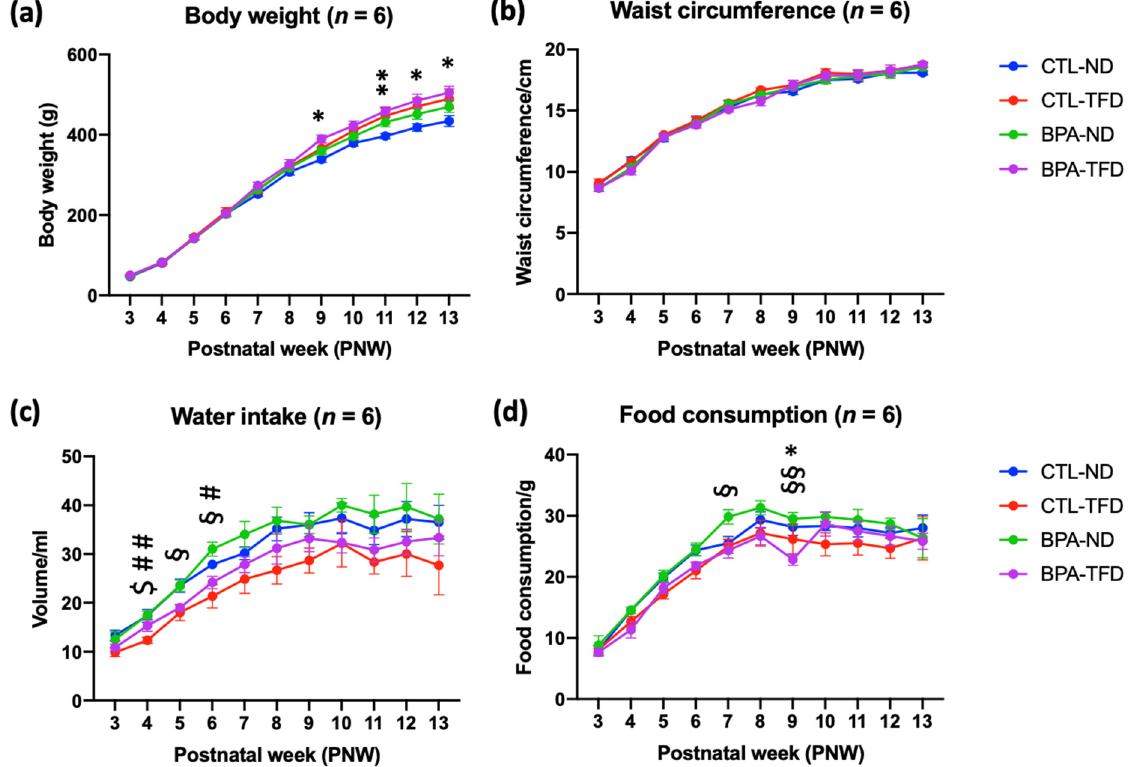
Figure 2. Physiological parameters for obesity in offspring: ( a ) body weight, ( b ) waist circumference, ( c ) water intake, and ( d ) food consumption. Significant differences were observed in water intake first from PNW4–6, followed by food intake from PNW7–9 and body weight from PNW9–13. Interestingly, the waist circumferences of control and BPA offspring on a normal or a trans fat diet were not substantially different from each other. Overall, TFD offspring were heavier than their normal diet counterparts, although they showed lower food and water intake. * p < 0.05 CTL-ND vs. BPA-TFD; ** p < 0.01 CTL-ND vs. BPA-TFD; $ p < 0.05 CTL-ND vs. CTL-TFD; # p < 0.05 CTL-TFD vs. BPA-ND; ## p < 0.01 CTL-TFD vs. BPA-ND; § p < 0.05 BPA-ND vs. BPA-TFD; §§ p < 0.01 BPA-ND vs. BPA-TFD ( n = 6 offspring per Table 1. Physiological parameters for obesity in offspring (comparisons between groups). Substan- tial differences in water and food intake were observed at earlier ages (PNW4–9; at adolescence), while significant differences in body weight were only observed at later ages (PNW9–13; at adult- hood). Meanwhile, waist circumference was comparable among offspring groups ( n = 6 per group).